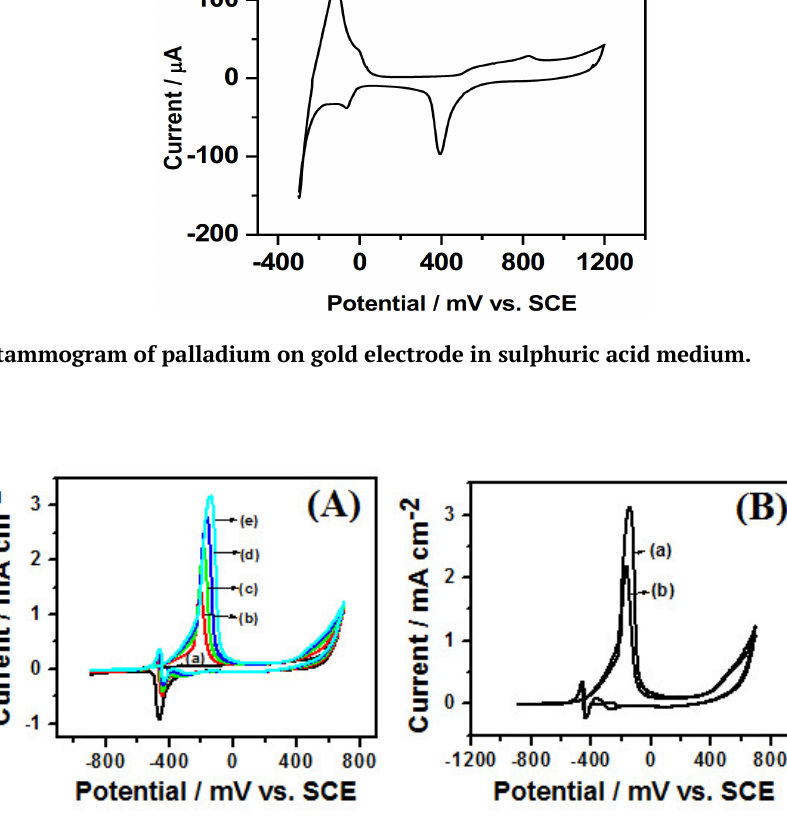
Figure 3. (A) Methanol oxidation of Pd NPs in alkaline medium and (B) Stability of the Pd NPs in